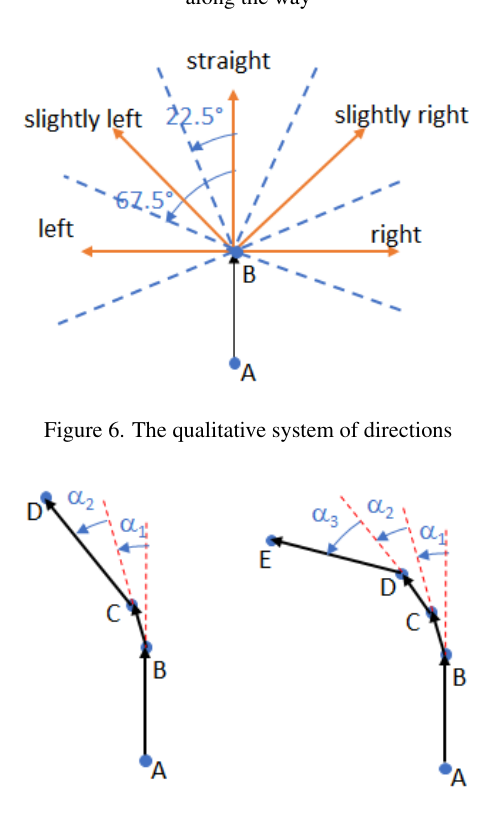
Figure 5. Circular buffer around a current node of the path to establish whether there are rooms (or door nodes) encountered along the way